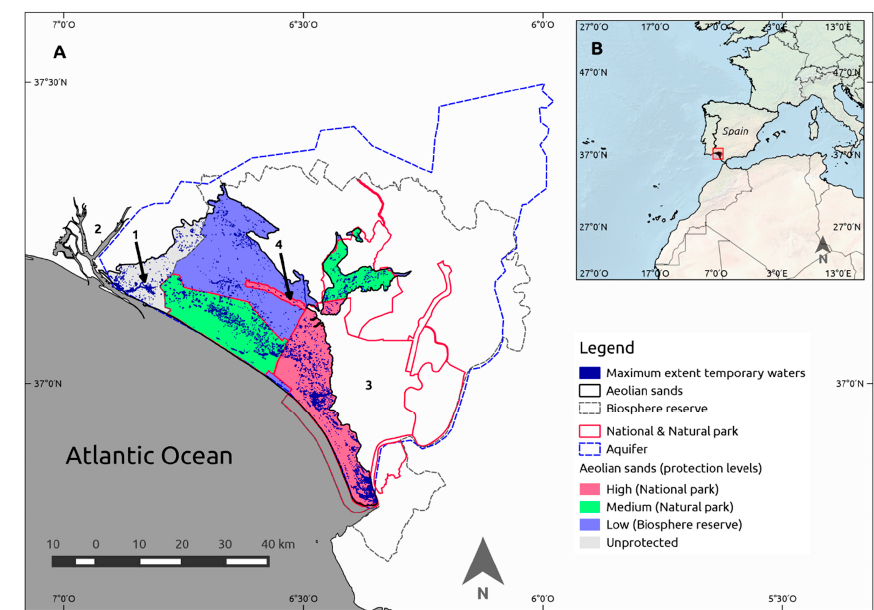
Figure 1. ( A ) Study area. The colored areas represent the Doñana’s aeolian sands and the different colors represent different levels of protection. The maximum extent of temporary waters is overlaid on the aeolian sands. Lines indicate the limits of the “Almonte-Marismas” aquifer, Doñana National Park, Natural Park, and Biosphere Reserve; ( B ) Location of the study area in southwestern Spain. Numbers locate some areas mentioned in the text: (1) Paraje Natural Lagunas de Palos y Las Madres ; (2) Tinto and Odiel marshes; (3) Doñana marshes; (4) Rocina protection